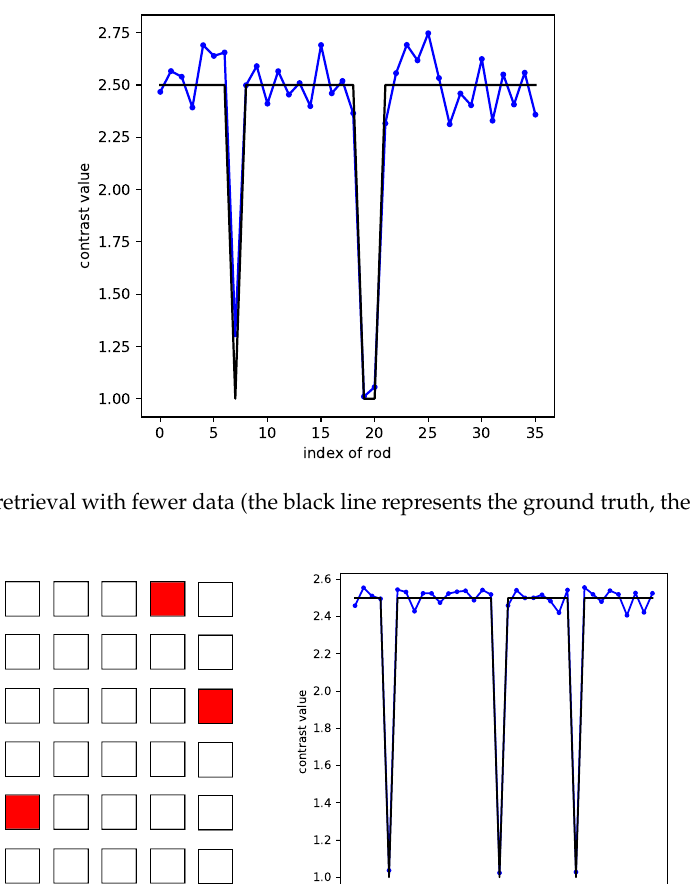
Figure 13. CRNN retrieval at the 3 GHz operation frequency, from left to right: 1, 2, and 3 missing rods (the black line represents the ground truth, the blue line the CRNN results).